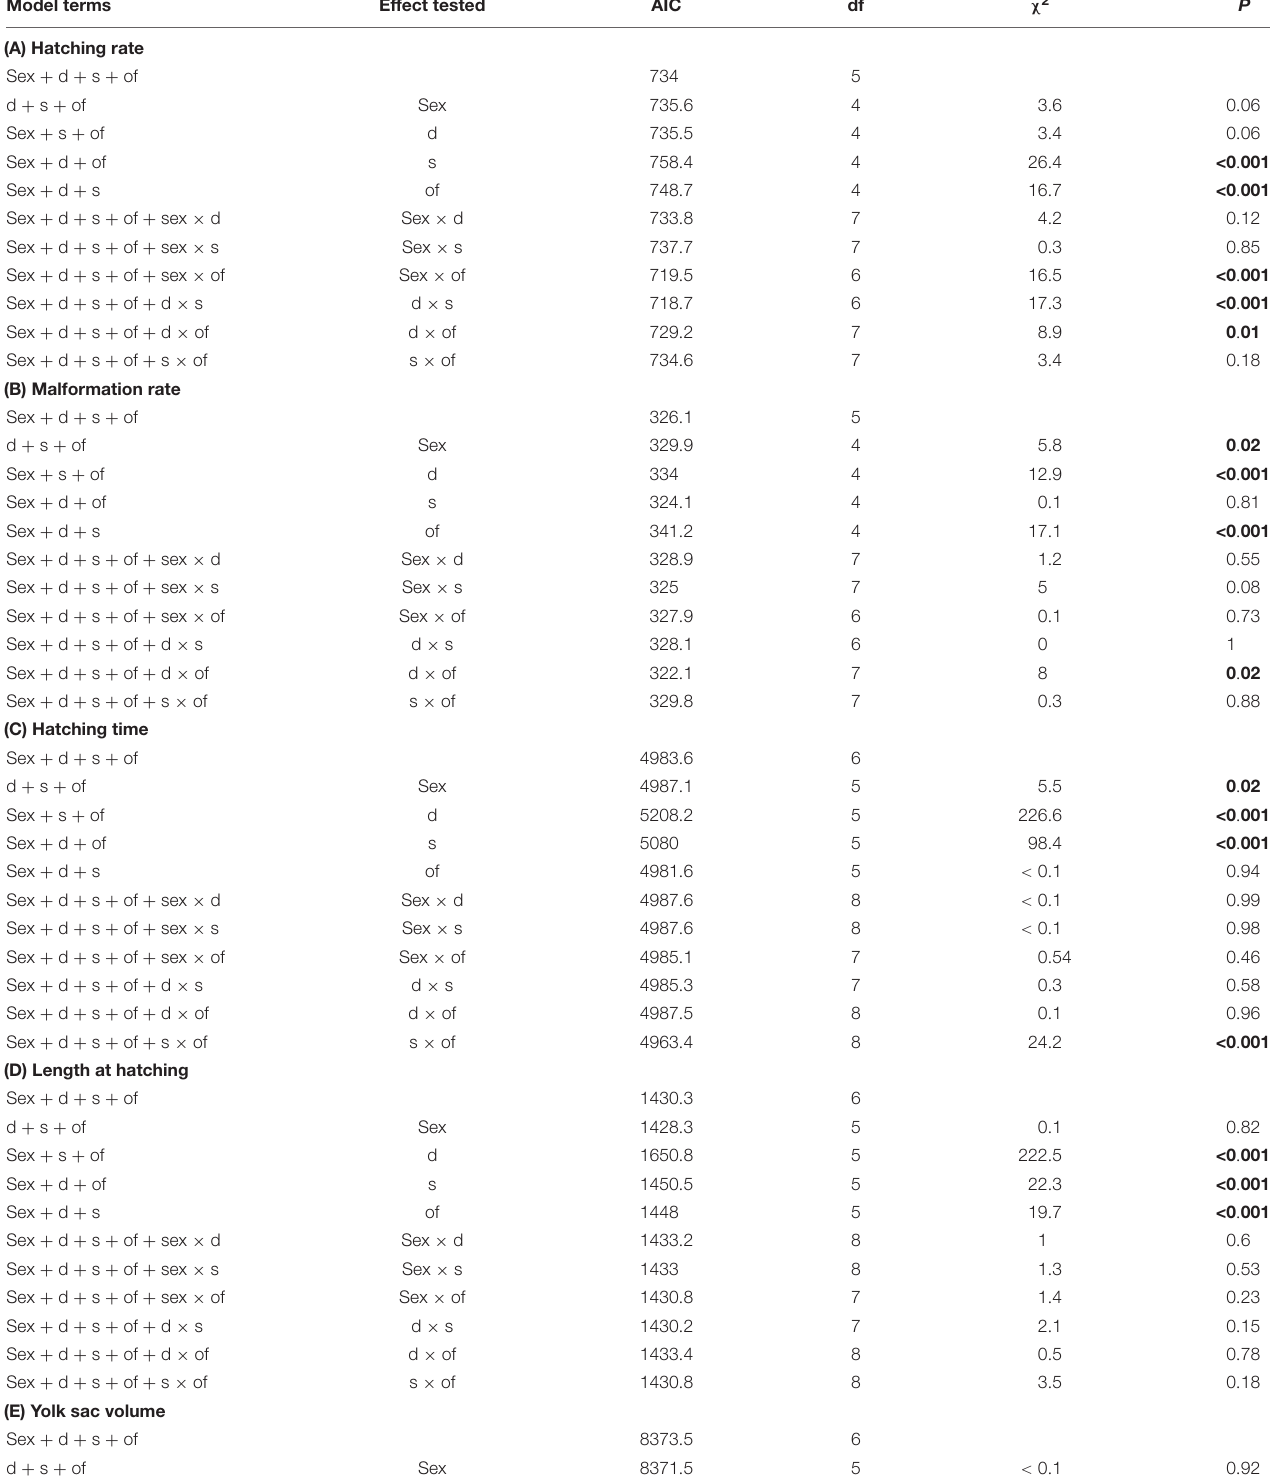
TABLE 2 | Likelihood ratio tests on generalized mixed-effects models on (A) embryo hatching rate and (B) malformation rate, and likelihood ratio tests on linear mixed-effects models on (C) hatching time, (D) larval length at hatching, (E) yolk sac volume at hatching, and (F) increase in larval length during the first 14 days after